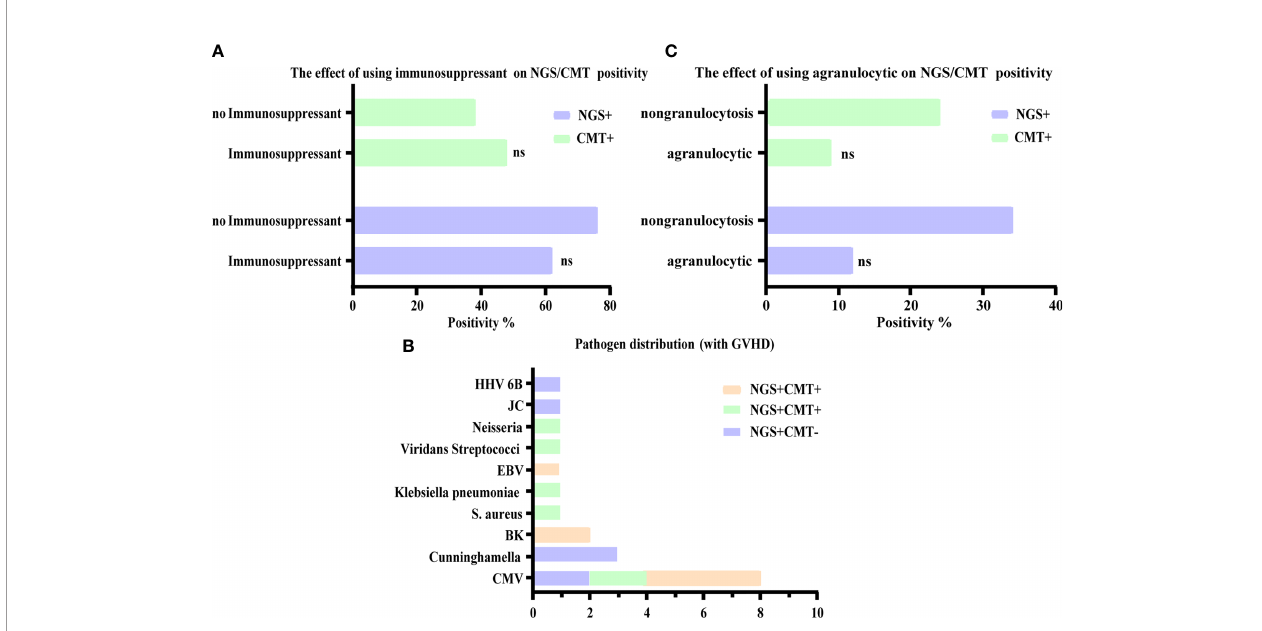
FIGURE 4 | In fl uence of other factors on the diagnostic accuracy of NGS and CMT. (A, C) Respectively shown that the positive microbiological detection rate of NGS and CMT was no signi fi cant correlation with immunosuppression and agranulocytic. (B) The number of detected microbes in patients with GVHD were presented, of which mainly were CMV. ns, non-signi fi cant statistical